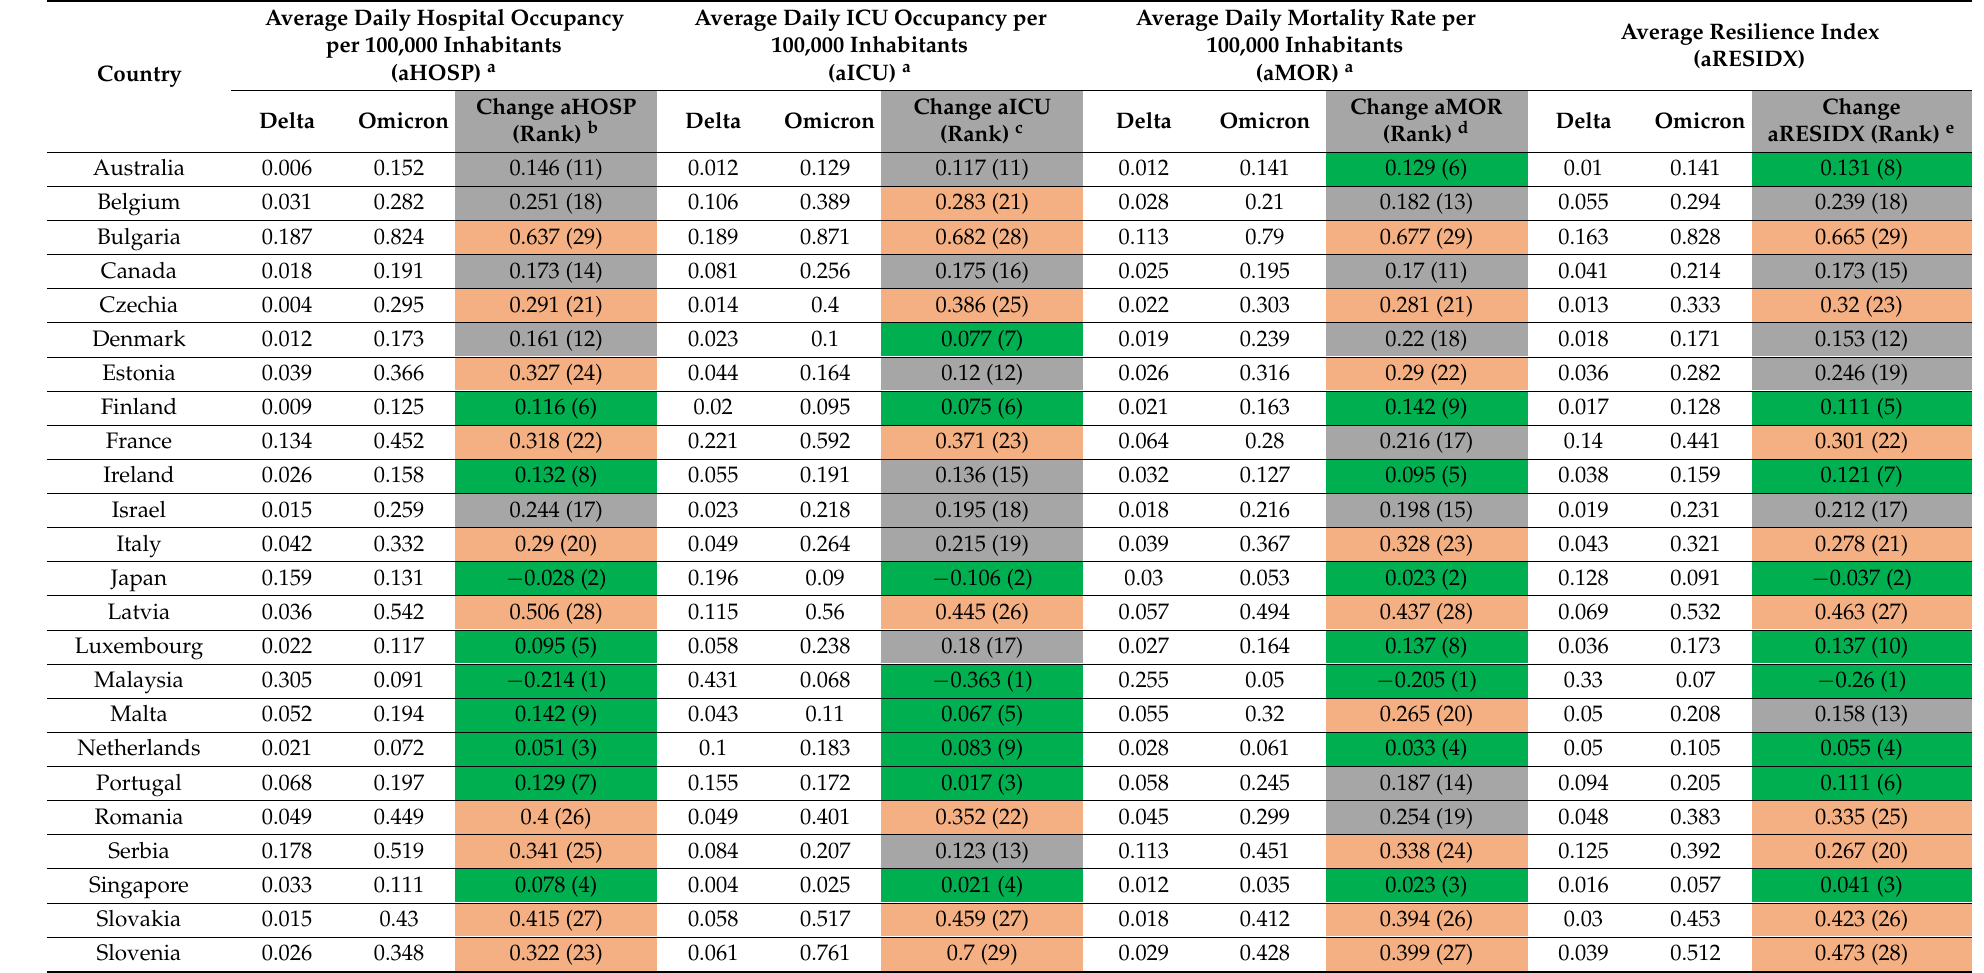
Table 3. The average of standardized values of hospital occupancy rate, ICU occupancy rate, mortality rate, and resilience index across countries between the two